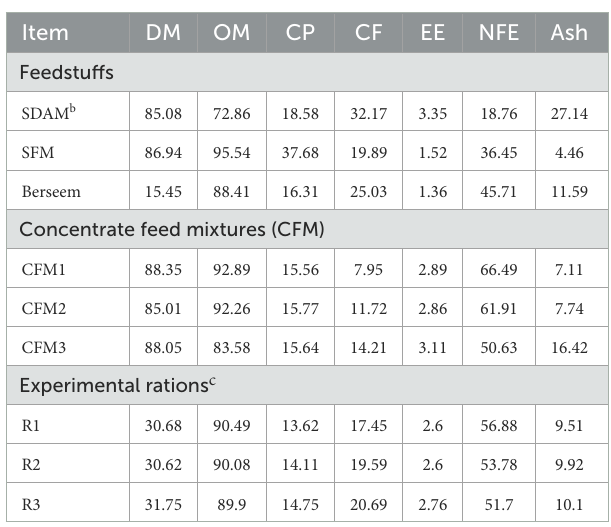
TABLE 2 Chemical composition a of feed ingredients of tested diets (% per DM